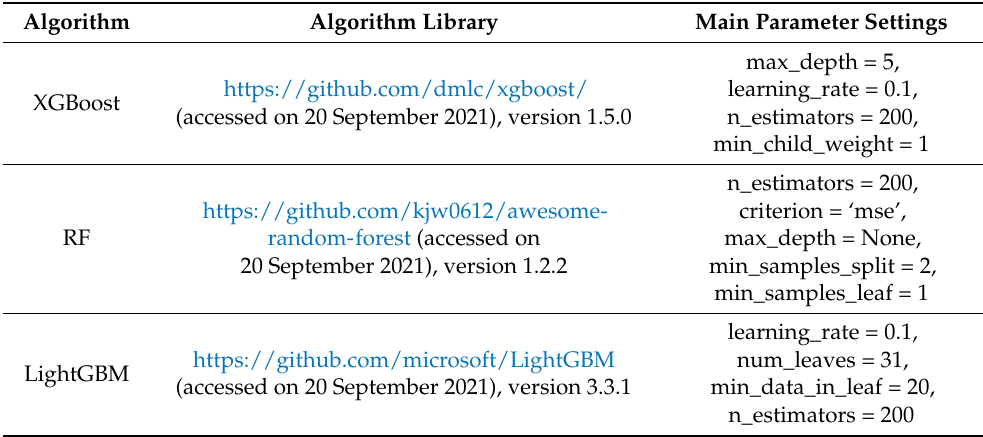
Table 5. Main parameter settings of the three machine learning